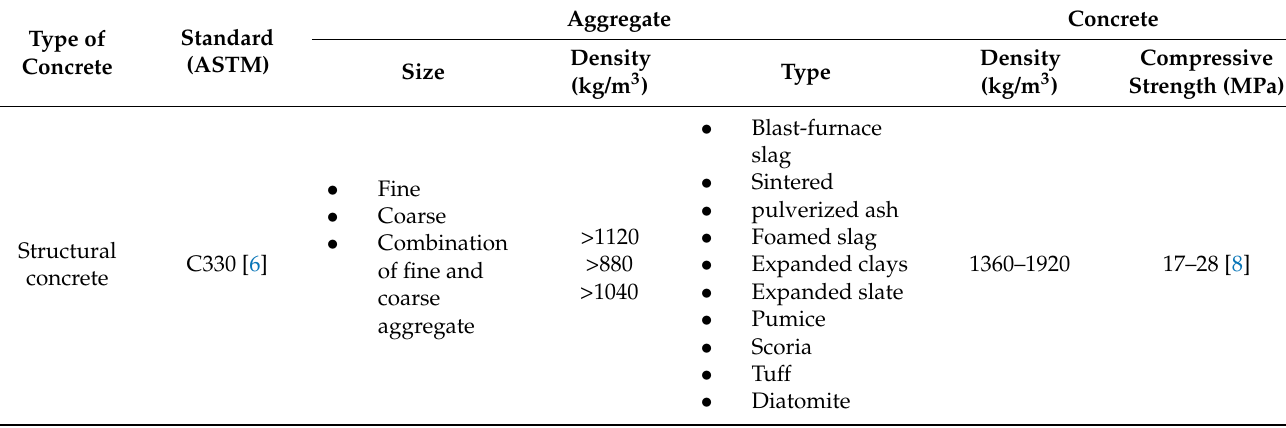
Table 1. Comparison Between different types of lightweight aggregate concrete. Type